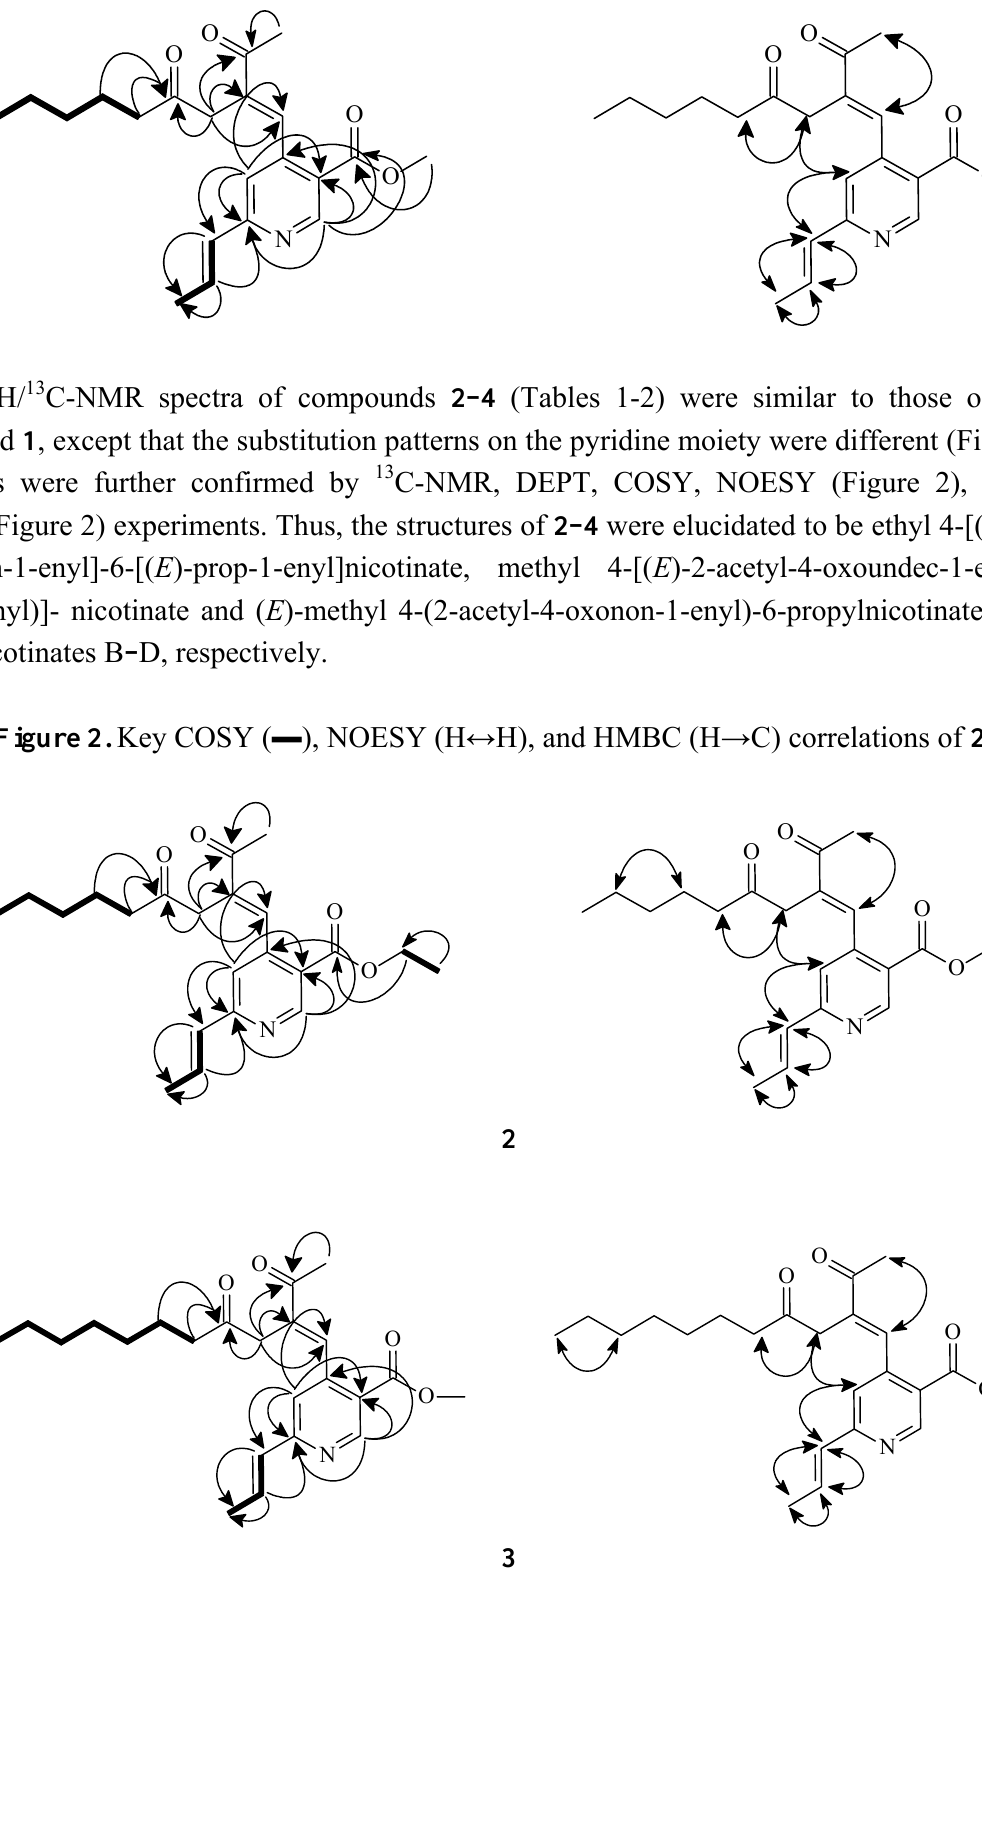
Figure 1. Key COSY ( ▬ ), NOESY (H ↔ H), and HMBC (H → C) correlations of 1 .